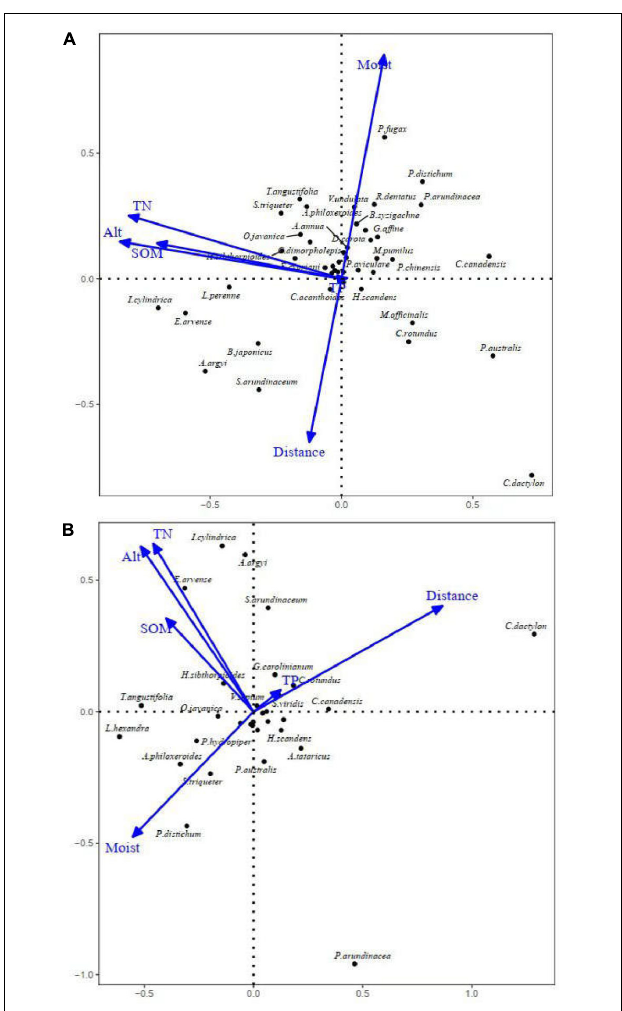
FIGURE 3 | Redundancy analysis (RDA) ordination diagrams of the frequently observed species in quadrats along the middle and lower reaches of the Hanjiang River. (A) RDA ordination diagram of 131 quadrats in June 2019; (B) RDA ordination diagram of 134 quadrats in October 2019.